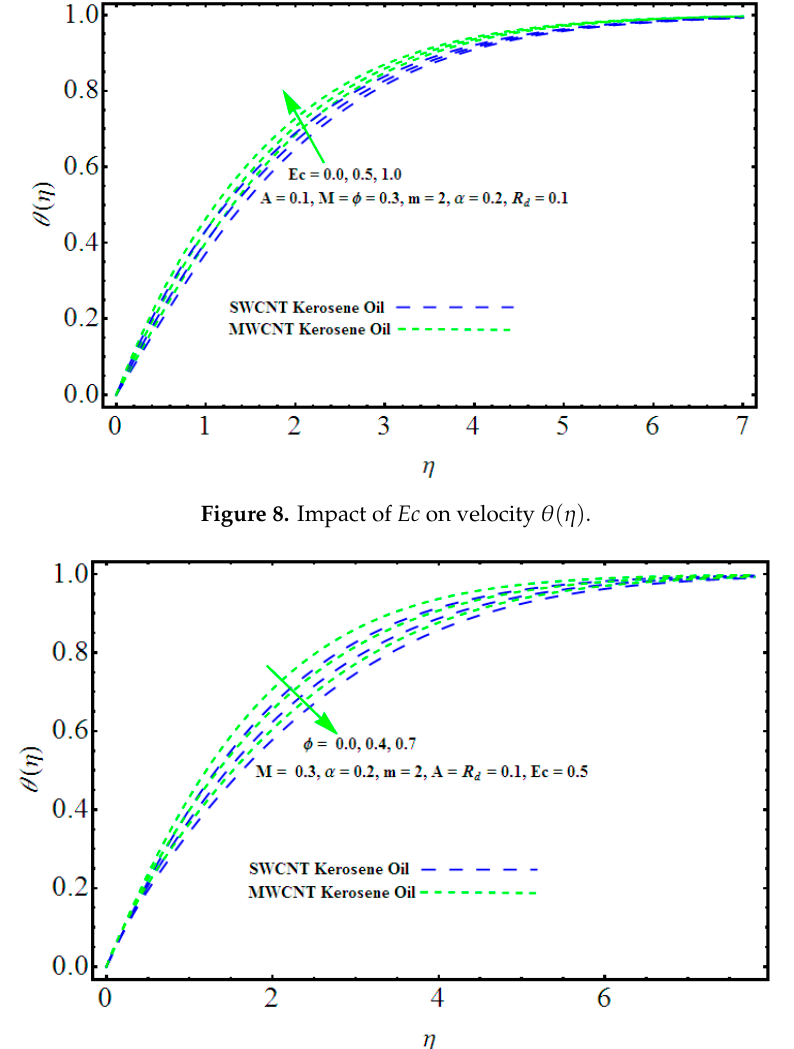
Figure 7. Impact of 𝑚 on velocity 𝑓 (cid:4593) (𝜂) .